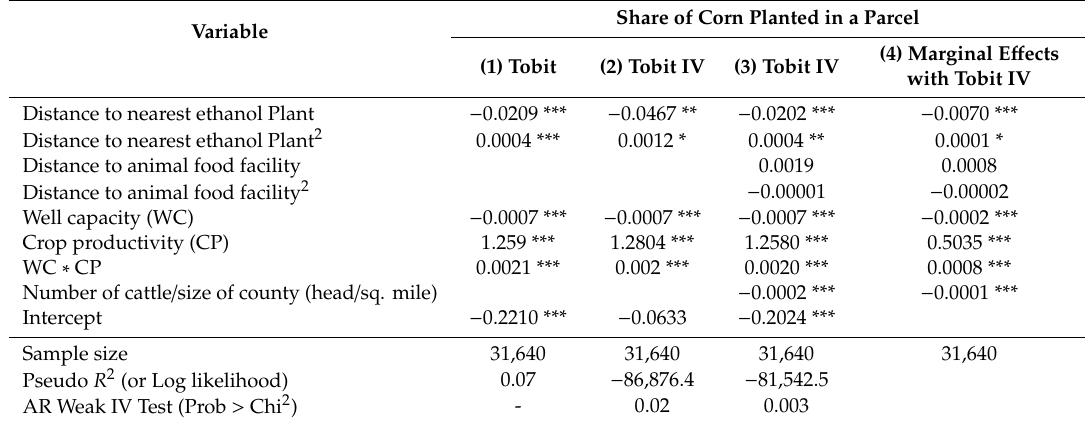
Table 4. Estimates for effects of local markets on corn planted.